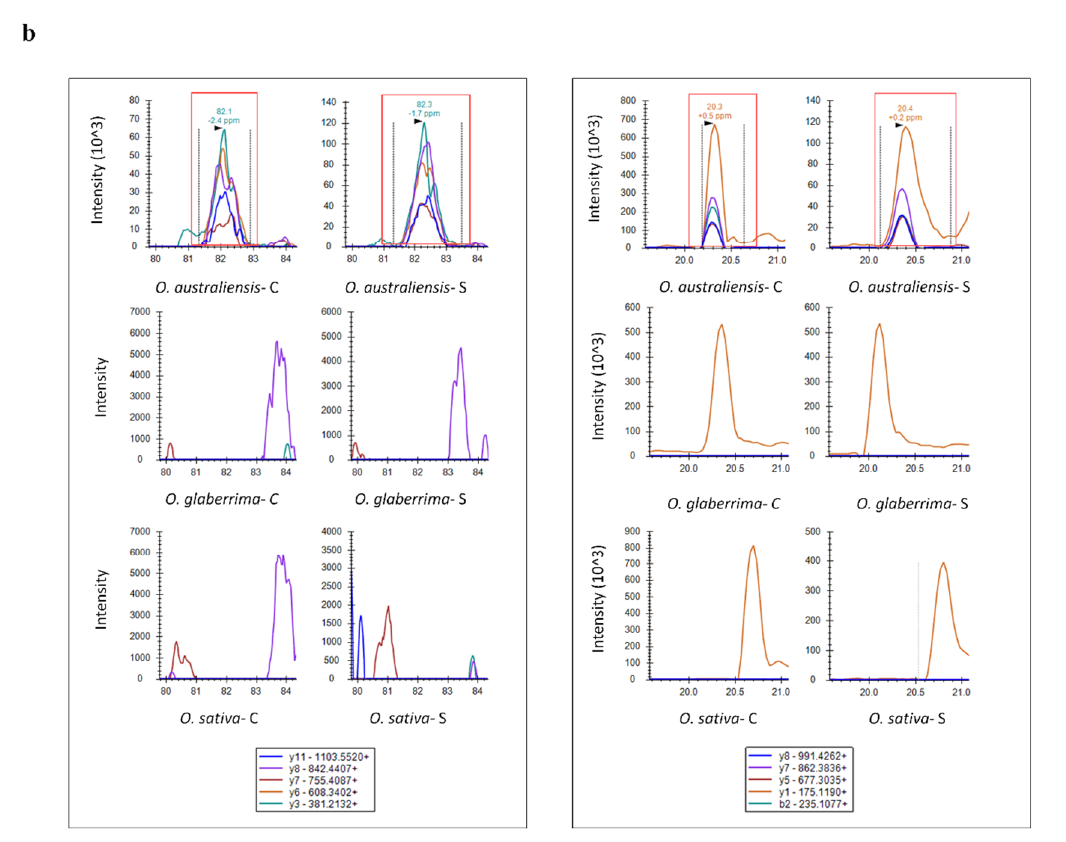
Figure 6. Parallel Reaction Monitoring (PRM) validation of drought stress-responsive proteins. ( a ) Bars illustrate the relative abundance of proteins (Log 2 area) in three rice species under control (C) and drought stress (D) conditions. An asterisk (*) indicates a statistically significant difference between the control and drought conditions, according to a Mann–Whitney U-test ( p -values < 0.05). ( b ) PRM transitions used for targeted verification of AAGDGDGGFSFGGLFSK.